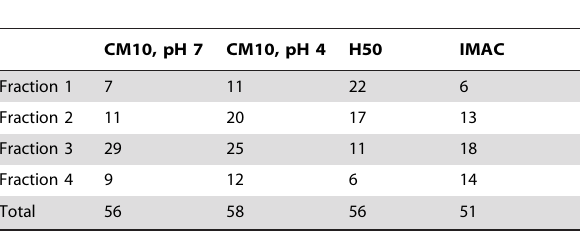
Table 3. Plasma proteome profiles